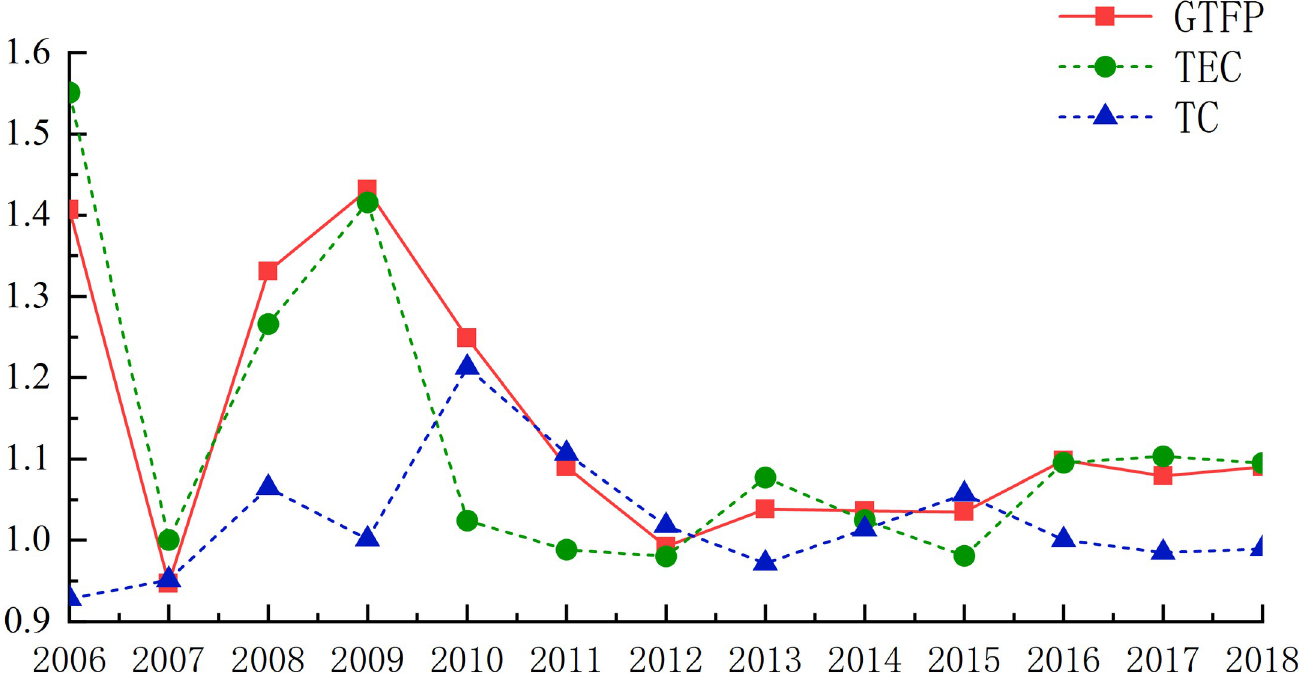
Fig 3. 2006–2018 industrial green total factor productivity and its index